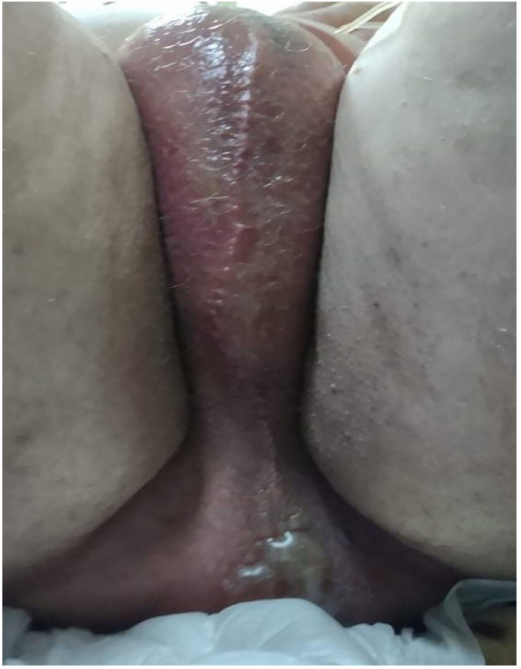
Figure 2. Patient’s skin: the aspect is erythematous, edematous, cyanotic, and hardy, with